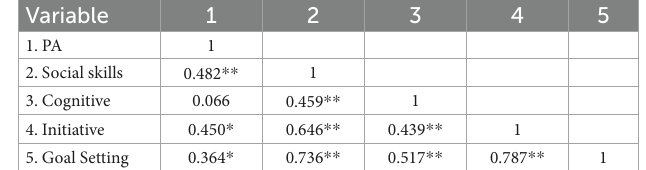
TABLE 2 Summary of treatment and the control group on entrepreneurship tendencies. Variables